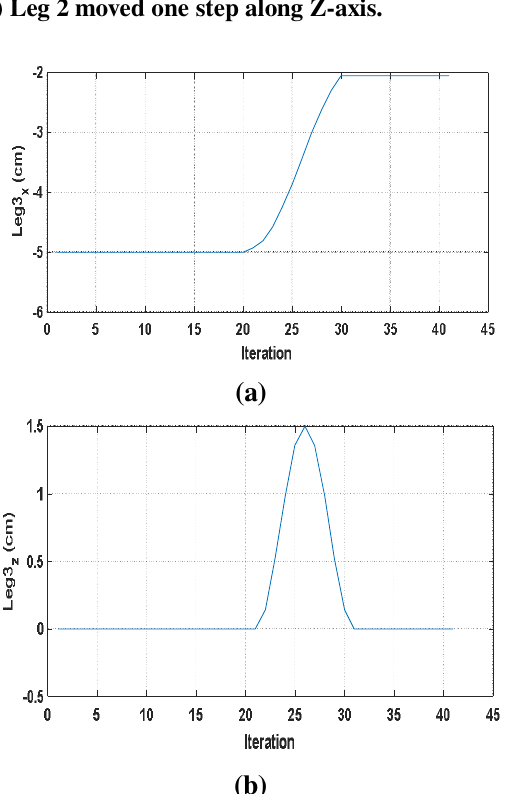
Fig. 18: When Leg 3 is swinging. (a) Leg 3 moved one step along X-axis. (b) Leg 3 moved one step along Z-axis.